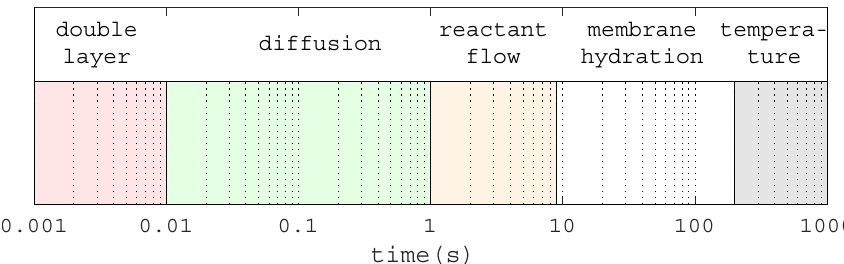
Figure 2. Time scales of the transient and dynamic phenomena in a Proton Exchange Membrane (PEM) fuel cell.